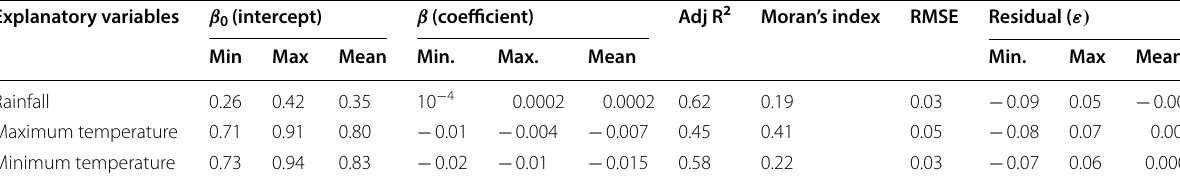
Table 9 Geographically weighted regression model results Explanatory variables